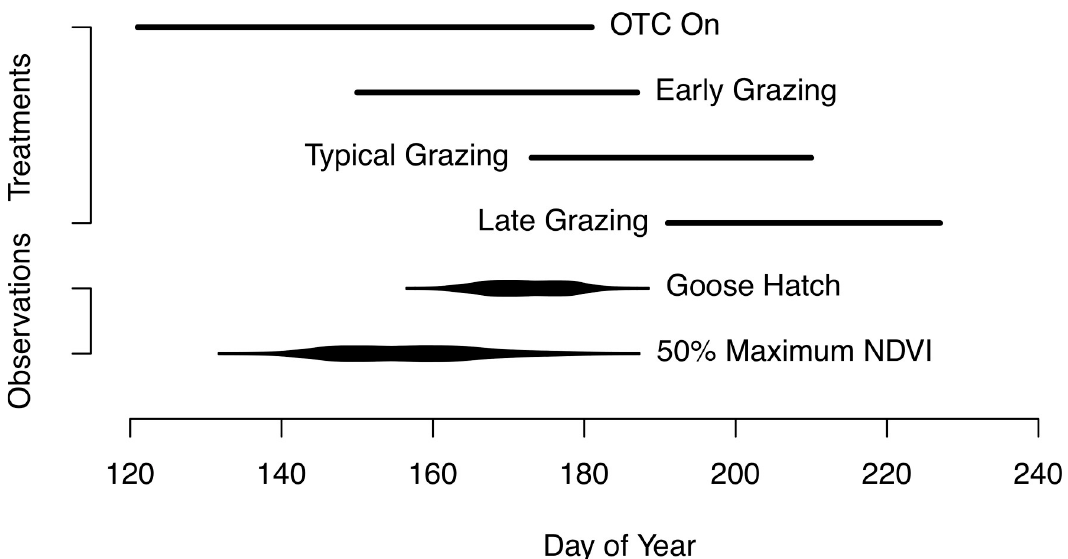
Fig 1. Timing of experimental treatments and observed events near the Tutakoke River in the Y-K Delta. Timing of experiment treatments for the advanced growing season [when the open-top chambers (OTCs) are on], and timing of late, typical and early grazing treatments. Hatch phenology data are from over 30 years (1984–2016) of direct observations [63, 77]. Also shown is the 50% maximum NDVI (normalized difference vegetation index) data from over 30 years (1982–2016) of observation [28]. Intensity of grazing increases following hatch when goslings begin to consume vegetation and females recover from nutrient deficits following nest incubation. Thus, early grazing treatments began shortly before the earliest mean hatch date. Typical grazing treatment started around the median hatch date. The late grazing treatment was timed to coincide with the latest mean hatch